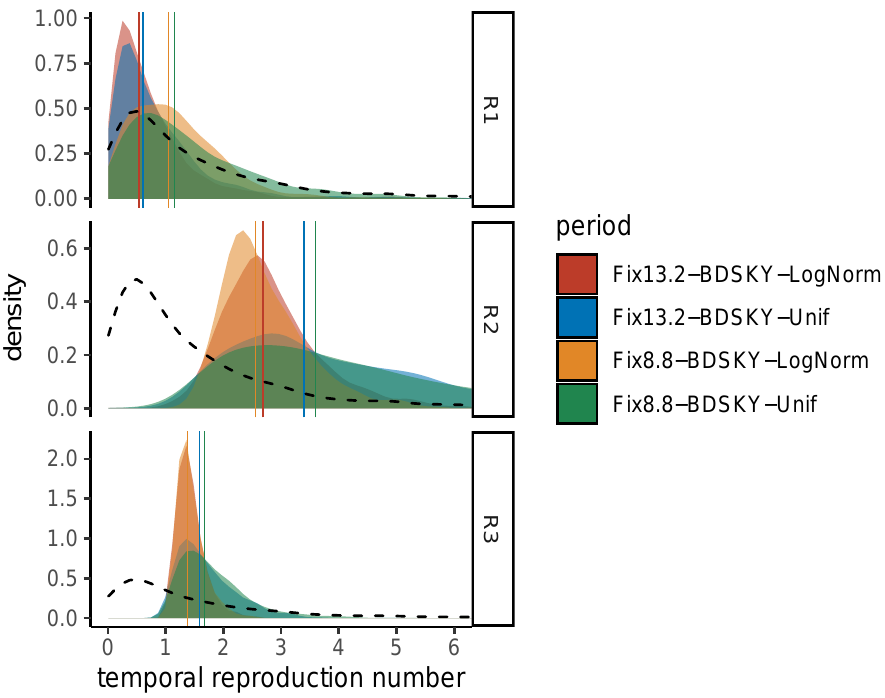
Figure S9 – Effect of the prior shape and of the molecular clock on the temporal repro- duction number estimate. The molecular clock value has a stronger effect than the prior shape except for , where the effect is limited. For , posterior distributions are close R 3 R 1 to the prior (black dashed line), as discussed in the main